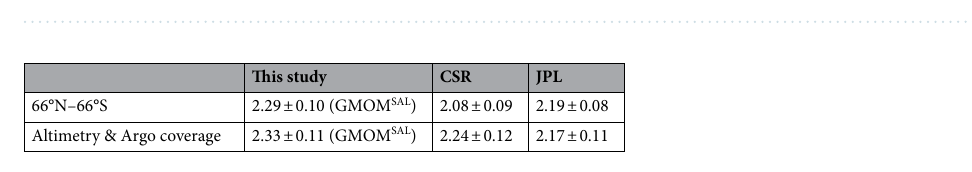
Table 1. GMOM comparisons between this study and Mascons.